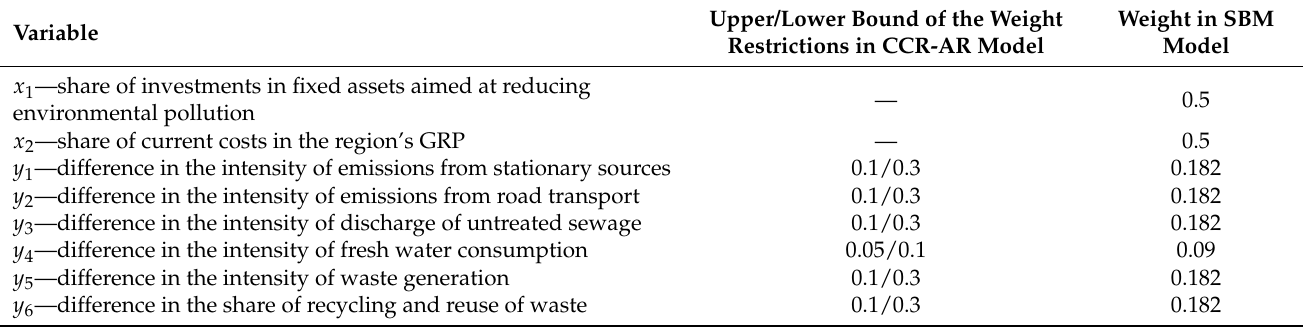
Table 3. Weights in CCR-AR and SBM